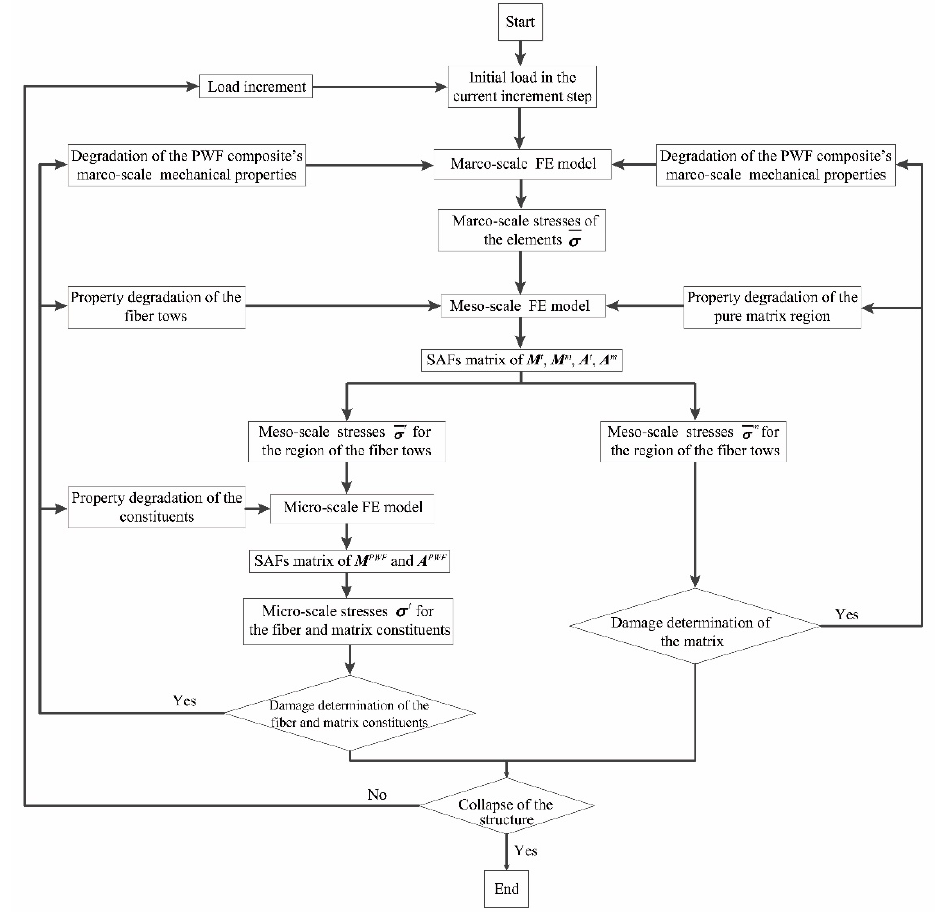
Figure 24. The multi-scale failure analysis method for the PWF composite structures.